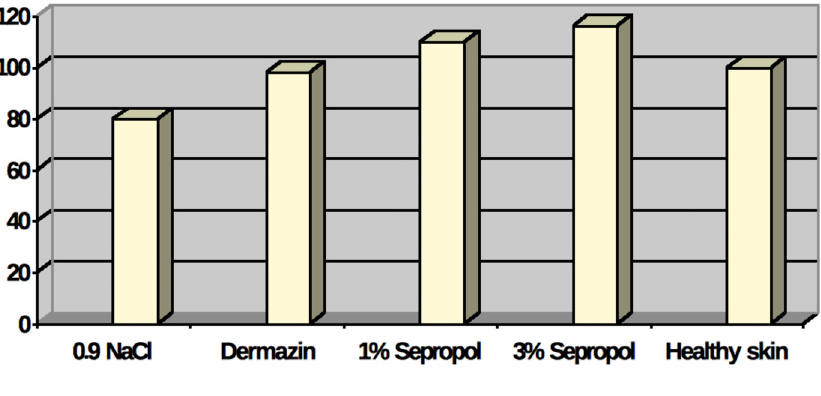
Figure 9. Proportional level of collagen in burn wounds scars on the 28th day of the experiment as compared to healthy skin. Collagen level in healthy skin is assumed to equal